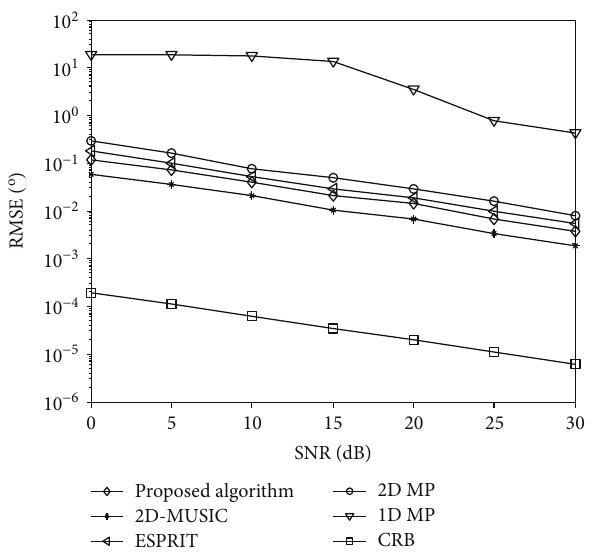
Figure 11: Performance comparison of di ff erent algorithms for DOA